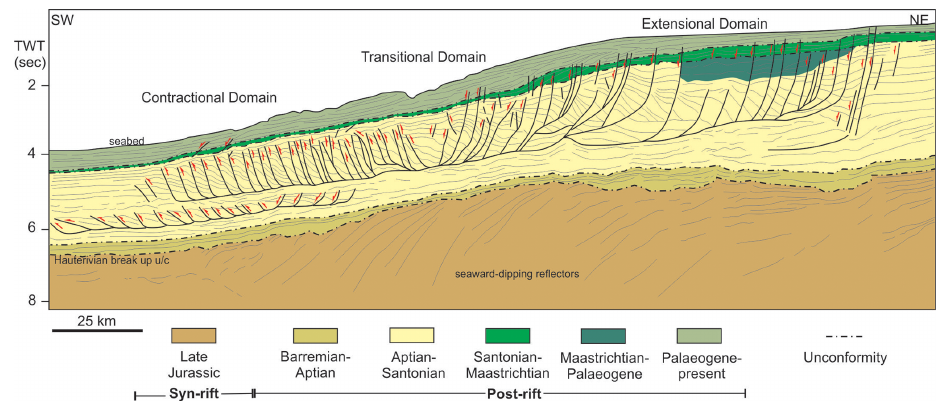
Figure 3. Two-dimensional profile of the Orange Basin showing structures with the up-dip extensional, central transitional (or translational), and down-dip compressional domains of a Cretaceous DWFTB system upon the Late Jurassic syn-rift sequence (de Vera et al.,